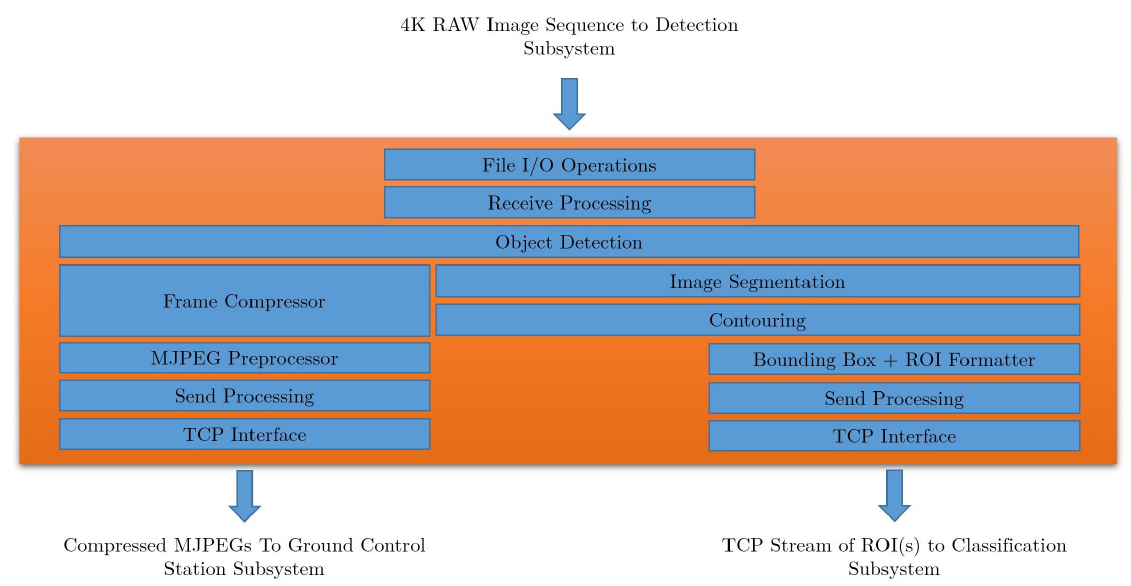
Figure 4. Detection subsystem block